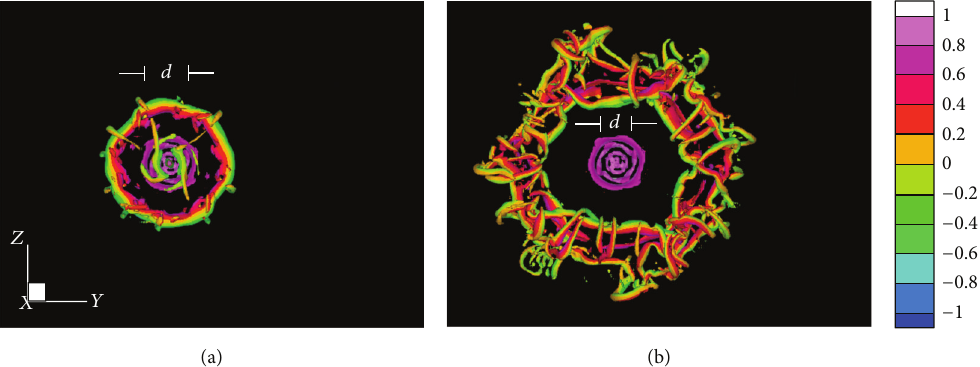
Figure 2: Cross-sectional visualization of isovortex cores ( 𝜆 2 = −50 , flood by axial velocity 𝑢 𝑥 ) at 𝑆 3 = 0.59 at 𝑡 = 5 (a) and 𝑡 = 15 (b) in the central